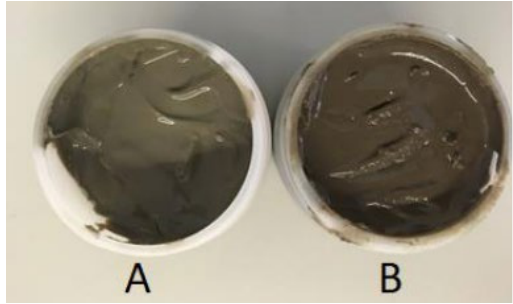
Figure 2. Control mask ( A ) and OPP mask ( B ).